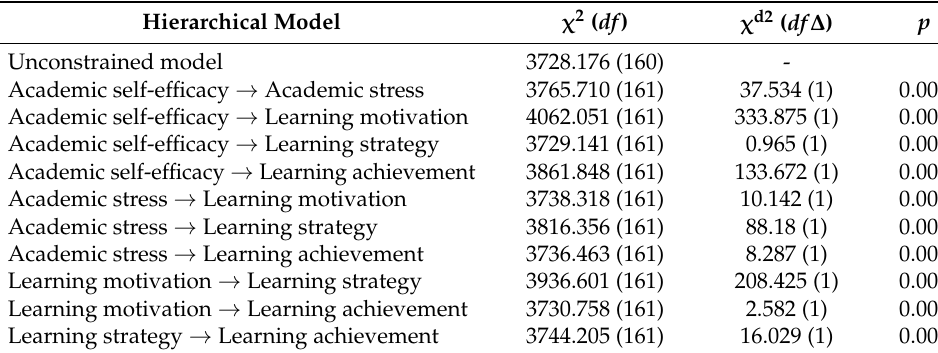
Table 5. Equality Constraints Analysis of the Structural Equation Models of Middle and High School Student